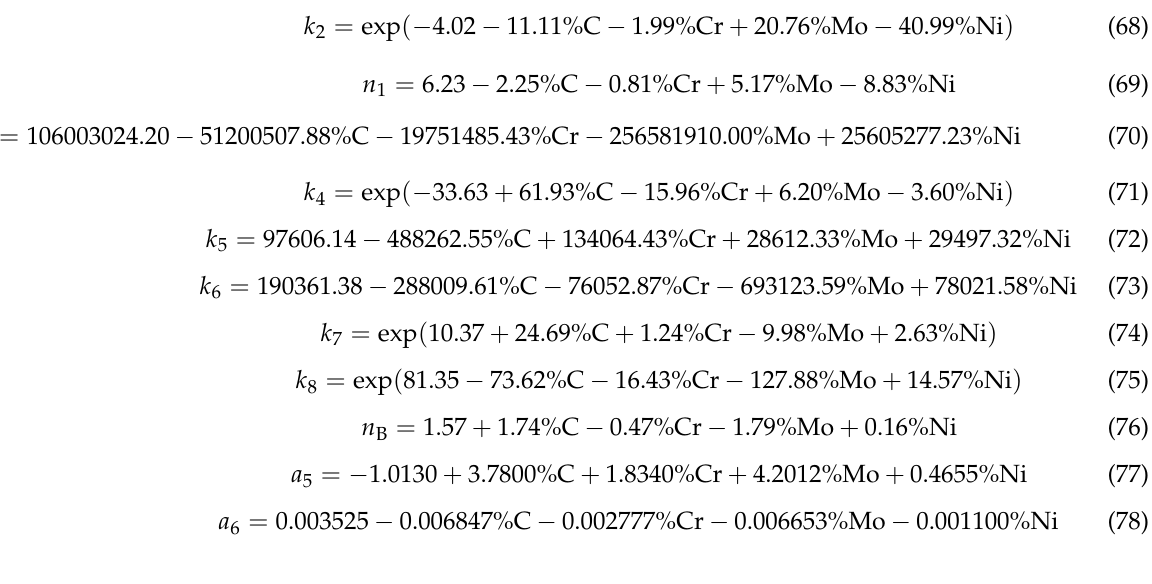
Table 2. Kinetic parameters of austenite isothermal